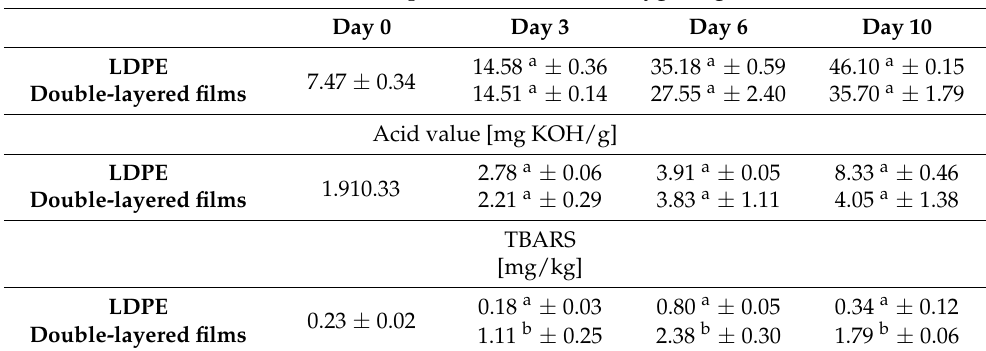
Table 4. Lipid oxidation of fish samples through storage in 4 ◦